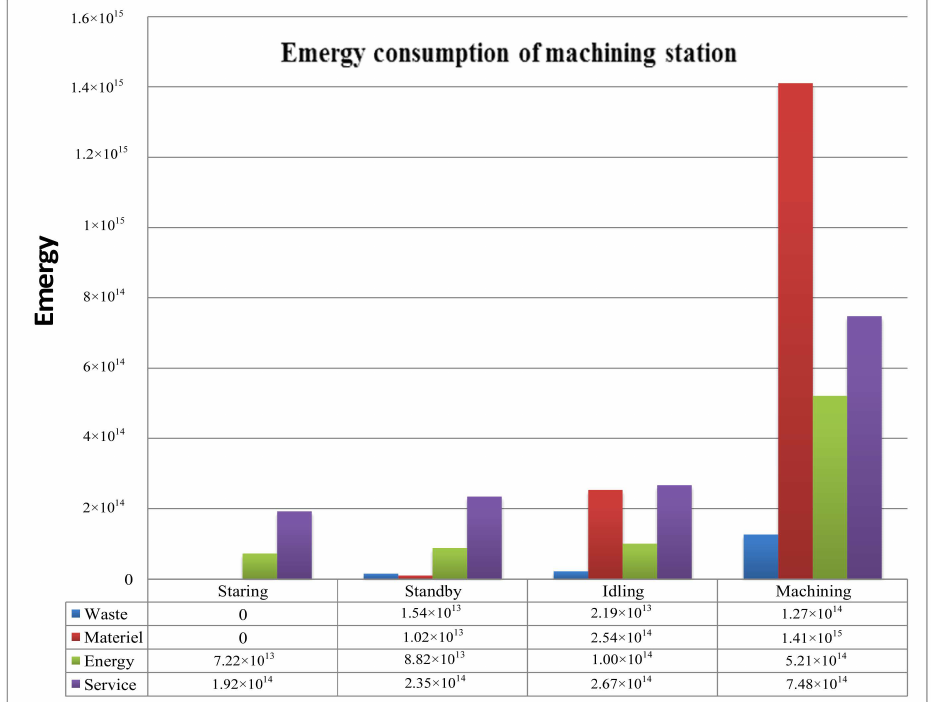
Figure 3. Emergy consumption of machining